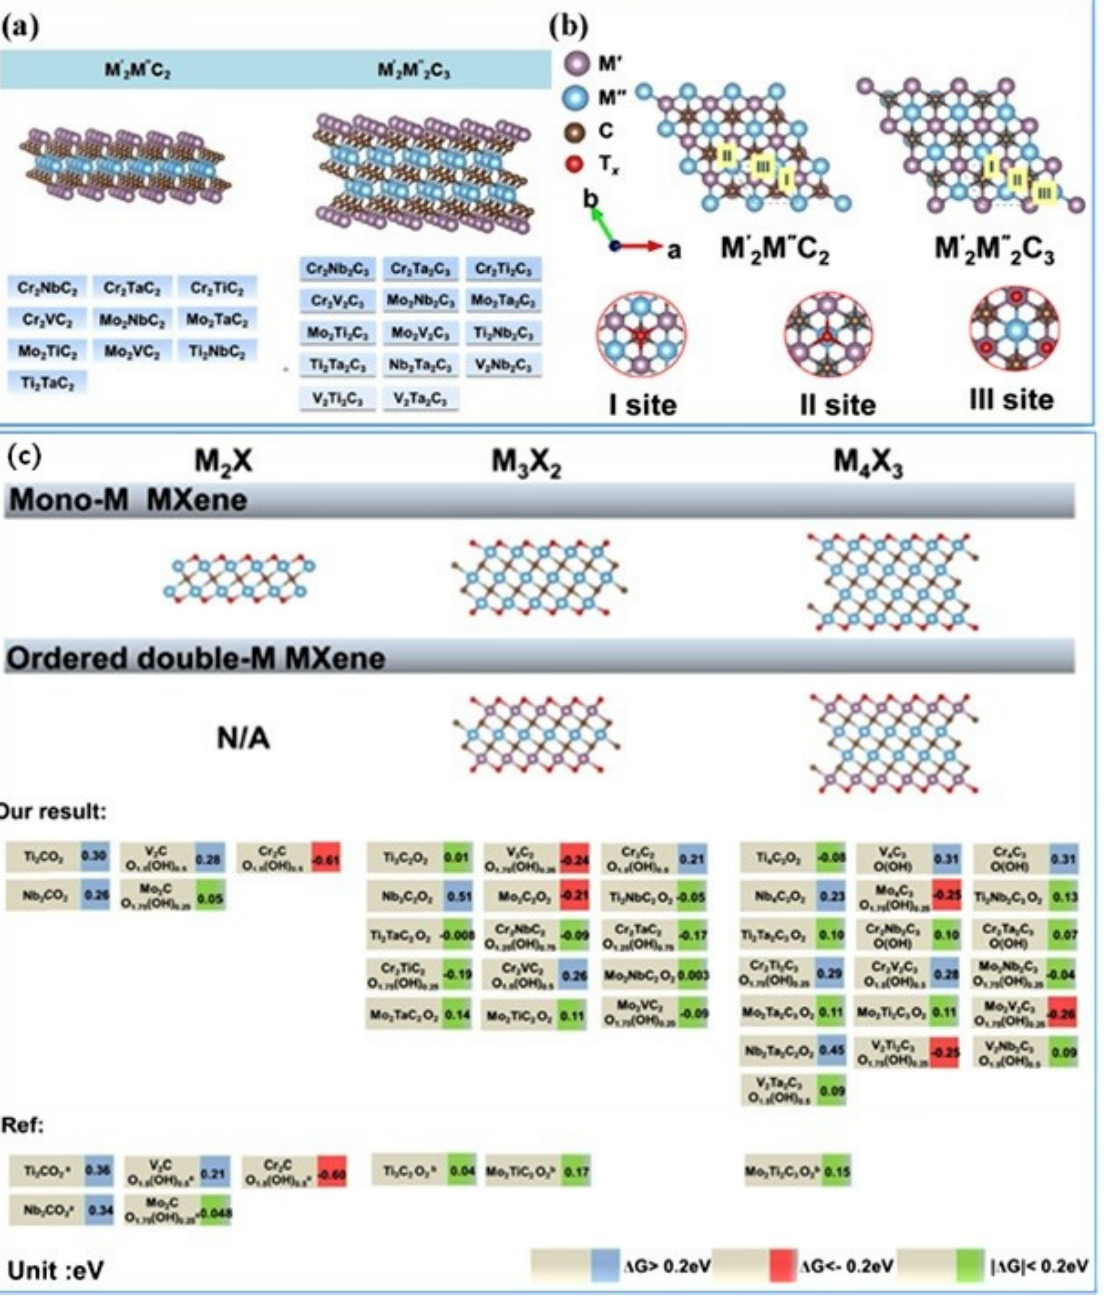
Figure 4. ( a ) List of ordered double TM carbides investigated in this work. ( b ) Atomic structure of M2 ′ M ″ C2 and M2 ′ M2 ″ C3 viewed from the top. The “I site”, “II site” and “III site” represent three high-symmetry adsorption sites for − O and − OH termination on the outermost layer. Color code: M ′ (blue), M ″ (purple), C (brown) and Tx (red). ( c ) Calculated Gibbs free energy (in eV) for single M2 ′ C, M3 ′ C2 and M4 ′ C3 (M ′ = Ti, V, Cr, Nb and Mo) carbide MXenes and corresponding values for investigated double TM MXenes. (Reprinted with permission from Ref. [70]. Copyright 2020, American Chemical Society).